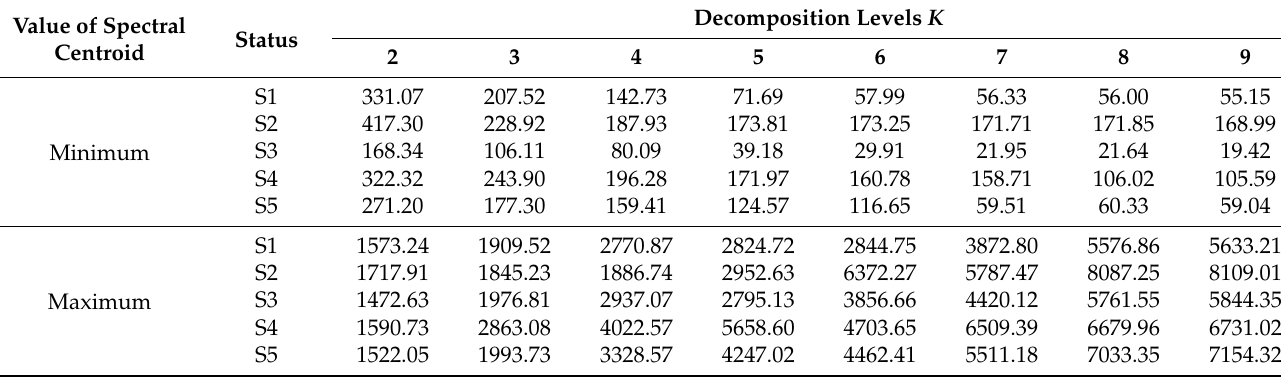
Table 4. Boundary values of the spectral centroid of the IMF for each state at different K-values.